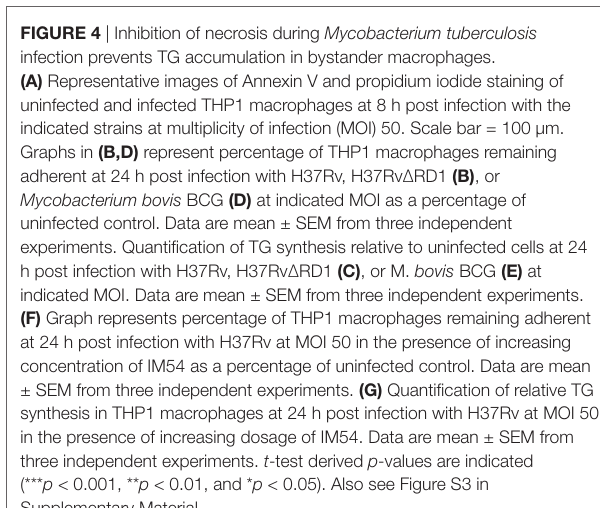
FigUre 4 | Inhibition of necrosis during Mycobacterium tuberculosis infection prevents TG accumulation in bystander macrophages. (a) Representative images of Annexin V and propidium iodide staining of uninfected and infected THP1 macrophages at 8 h post infection with the indicated strains at multiplicity of infection (MOI) 50. Scale bar = 100 μm. Graphs in (B,D) represent percentage of THP1 macrophages remaining adherent at 24 h post infection with H37Rv, H37RvΔRD1 (B) , or Mycobacterium bovis BCG (D) at indicated MOI as a percentage of uninfected control. Data are mean ± SEM from three independent experiments. Quantification of TG synthesis relative to uninfected cells at 24 h post infection with H37Rv, H37RvΔRD1 (c) , or M. bovis BCG (e) at indicated MOI. Data are mean ± SEM from three independent experiments. (F) Graph represents percentage of THP1 macrophages remaining adherent at 24 h post infection with H37Rv at MOI 50 in the presence of increasing concentration of IM54 as a percentage of uninfected control. Data are mean ± SEM from three independent experiments. (g) Quantification of relative TG synthesis in THP1 macrophages at 24 h post infection with H37Rv at MOI 50 in the presence of increasing dosage of IM54. Data are mean ± SEM from three independent experiments. t -test derived p -values are indicated (*** p < 0.001, ** p < 0.01, and * p < 0.05). Also see Figure S3 in Supplementary